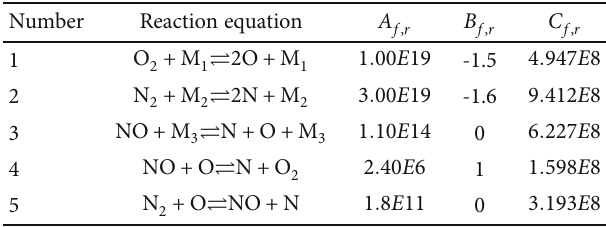
Table 1: Gupta chemical reaction model and reaction rate constants.